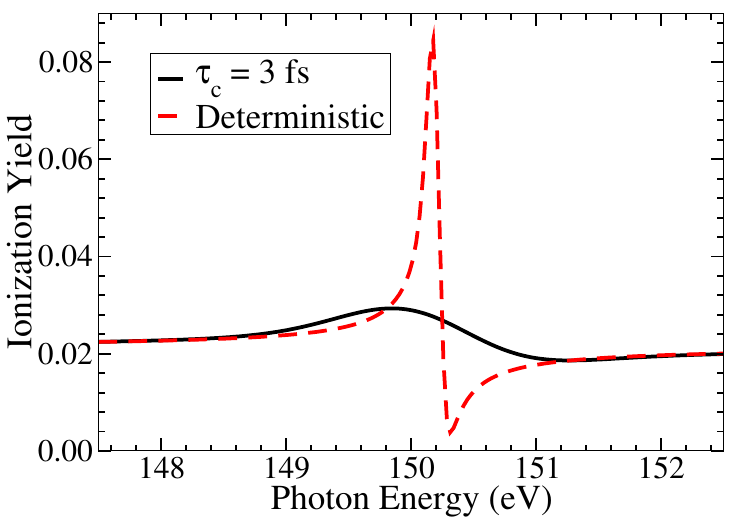
Figure 2. The effect of smoothing the familiar Fano-profile, caused by averaging the fluctuations can be clearly seen in this figure. The red-dashed curve with highest peak is obtained for a deterministic pulse whereas the black-solid curve is obtained for a stochastic pulse with coherence time of 1.3 fs (53.74 a.u.). The peak intensity is 10 13 W/cm 2 and the pulse duration τ p = 12.7 fs (525.02